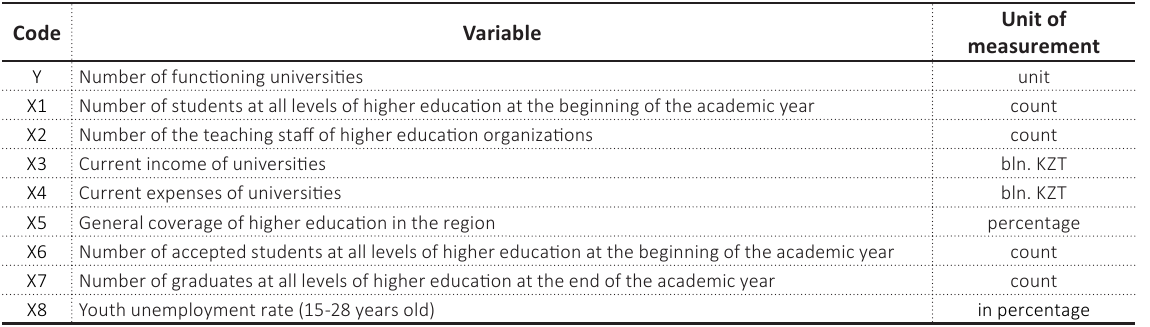
Table 1. Regression model factors